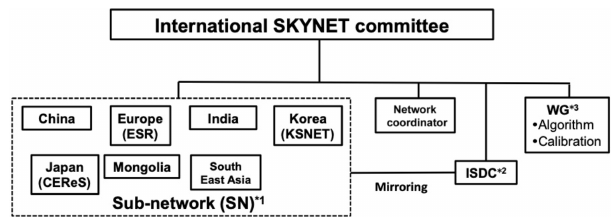
Figure 2. The structure of the International SKYNET